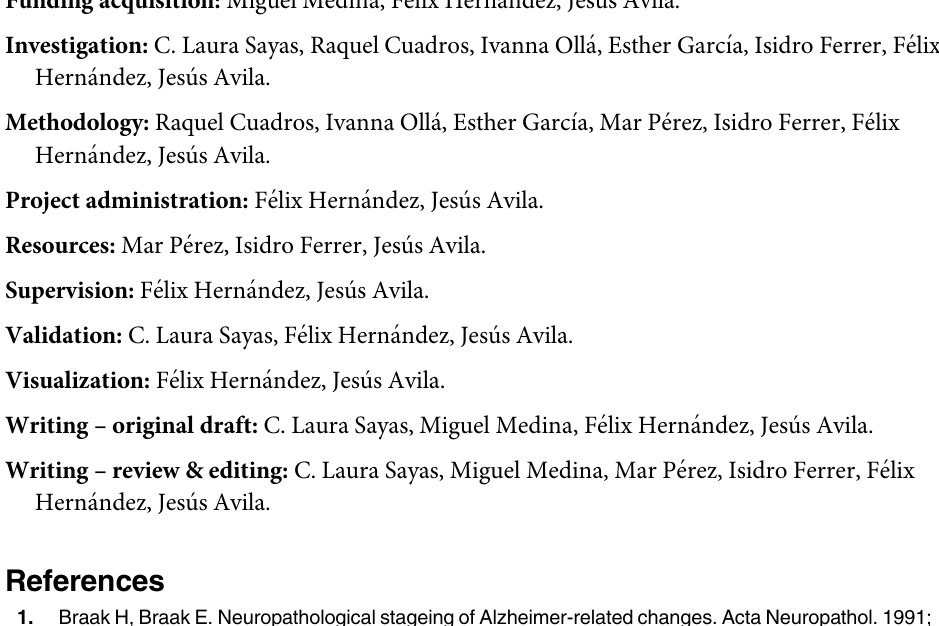
S1 Fig. Overexpression of EB proteins ( μ g plasmid per well) facilitates tau secretion. Addi- tional representative Western-blots for increased amounts of secreted tau observed in the cul- ture medium of HEK-293-tau3R cells overexpressing EB1 (upper panel) and EB3 (lower panel) tested with anti-tau antibody 7.51. S2 Fig. EB1 depletion decreases tau secretion. Additional representative Western-blot for decrease amounts of secreted tau observed in the culture medium of HEK-293-tau3R cells infected with EB1-shRNA-4 lentiviral particles (dilution 1/20 and 1/6 of supernatant contain- ing the lentiviral particles, see Methods section) tested with anti-tau antibody 7.51.